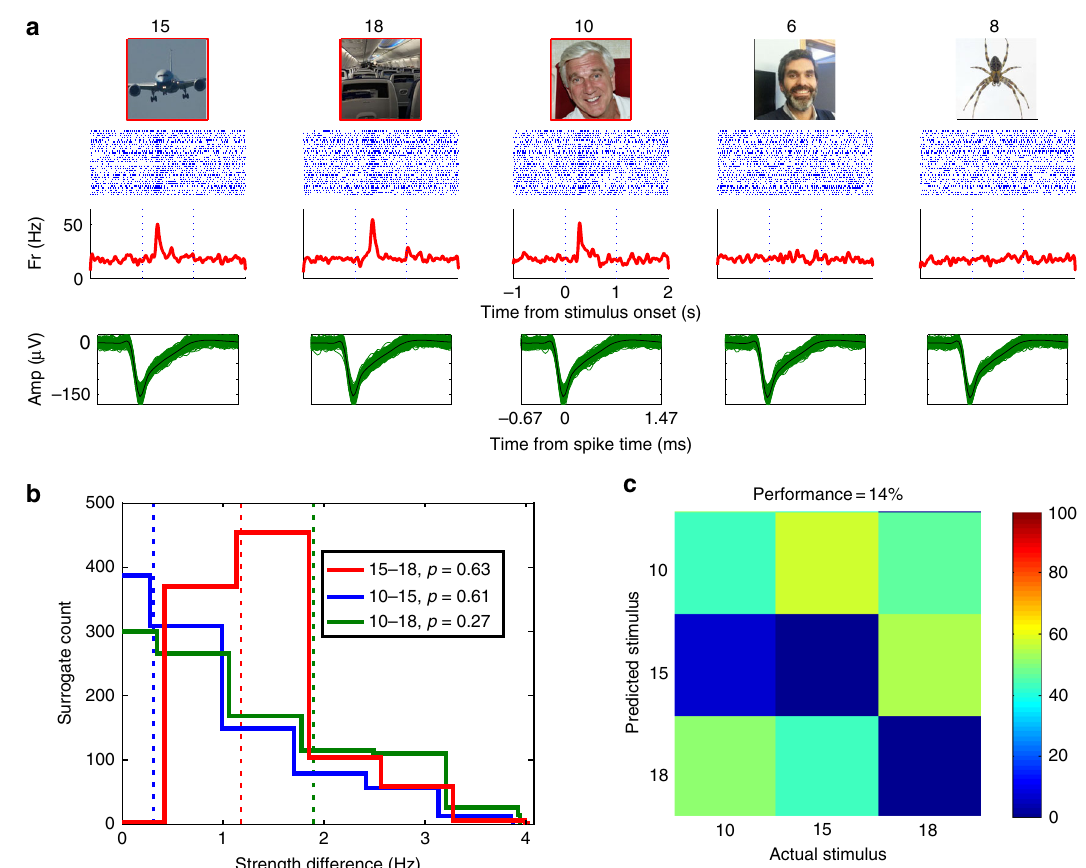
Fig. 1 Exemplary multi-responsive unit. a Responses of a unit in the left hippocampus. For each stimulus, the raster plot (blue lines represent the appearance of a spike and each row is associated to a trial; fi rst trial is at the top and time zero is the stimulus onset), instantaneous fi ring rate, and spike shapes in the response period (between 100 and 800 ms after stimulus onset), are shown. Stimulus numbers appear at the top of the stimulus pictures. The unit responded to the picture of a Boeing, the interior of a cabin airplane, and the actor Leslie Nielsen (who had a major role in the 1980 movie “ Airplane! ” ). The association scores for this unit (Methods) were AS = 0.3 and ASR = − 0.06, indicating a strong association between the response- R – R N – R eliciting stimuli. Note that the spike shapes are the same for all responses, indicating that they come for the same neuron. b Surrogate distributions of strength difference for each response-eliciting pair in this unit. Vertical dashed lines represent the actual strength difference for each pair. All three pairs showed no signi fi cant difference (stimuli 10 – 18, p = 0.27; stimuli 10 – 15, p = 0.61; stimuli 15 – 18, p = 0.63). c Confusion matrix based on the single trial spike count of the response-eliciting stimuli (the color code represents the percentage of trials where stimulus i was presented and the decoder labeled it as stimulus j ). Stimulus numbers are the same as in a . The decoding performance was 14%, not signi fi cantly different from chance ( p = 0.92). Due